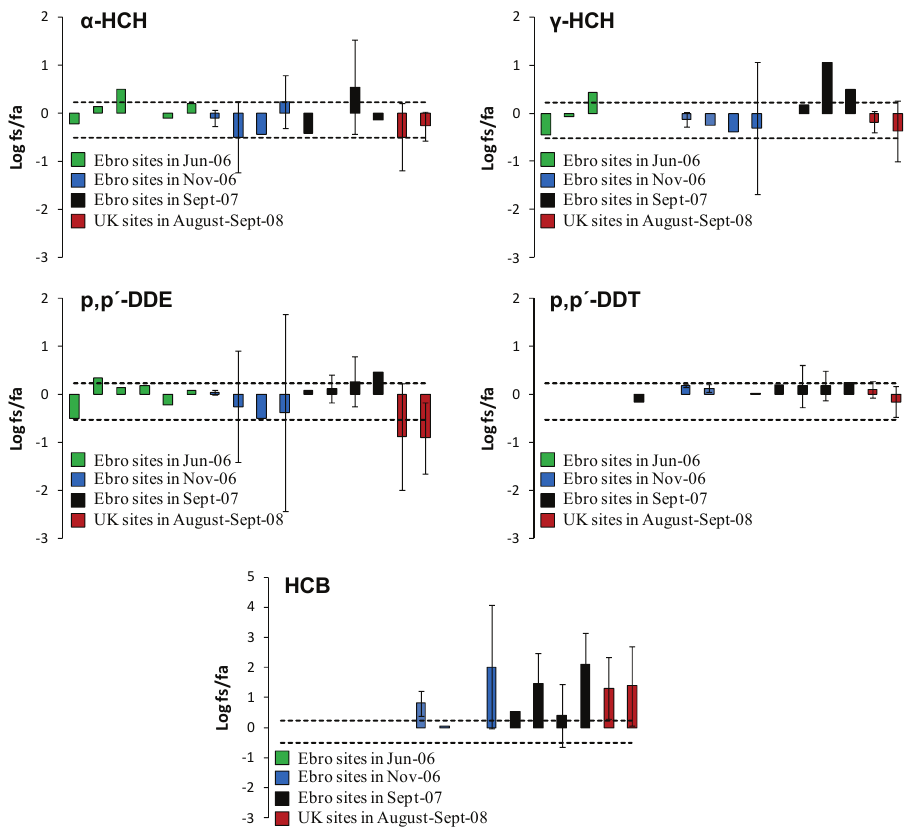
Fig. 4. Soil to air fugacity ratio ( f s / f a ) in logarithmic scale for the different sampling campaigns in Ebro (Spain) and UK. Dash lines indicates equilibrium (range +0.23, −